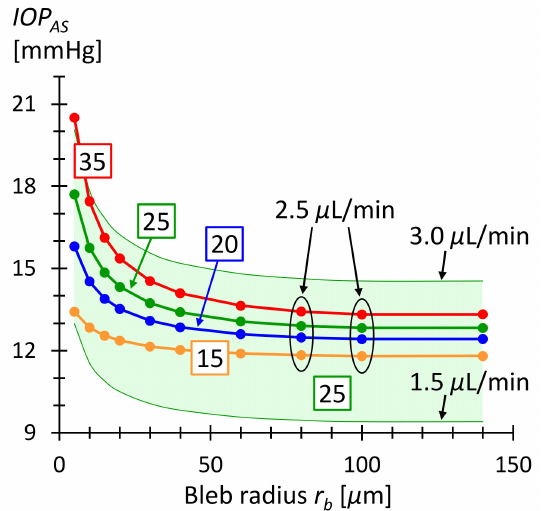
Figure 8. IOP AS as a function of microbleb radius r b . The bleb separation is d a = 300 µ m correspond- ing to the geometric period in the current honeycomb design. The numbers in the boxes are the IOP values before surgery in units of mmHg. The curves were calculated using Equation (16) and . Q . IOP AS ranges from 12 and 15 mmHg for bleb radii greater than 30 µ m. The green shaded area corresponds to the IOP AS for AH production rate varying between 1.5 and 3.0 µ L/min and an IOP before surgery of 25 mmHg. The green shaded area demonstrates that the IOP is within a healthy range even with daily fluctuating production rates